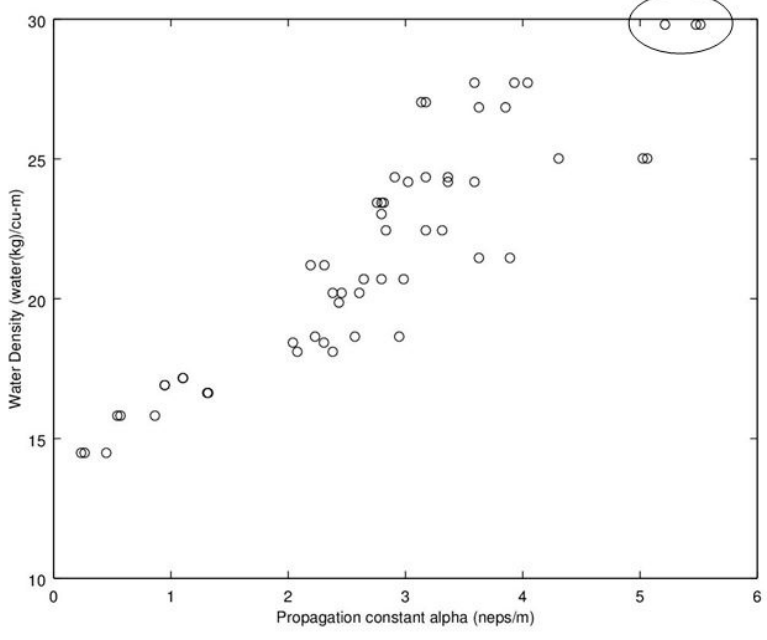
Figure 14. Graph detailing propagation attenuation constant, α , versus bulk water density at 1.5 GHz. Of interest is that the points on the excessively wet low-density module, circled, are moving closer together as the frequency increases. Note water density calculated from moisture content utilizing Equation (9).